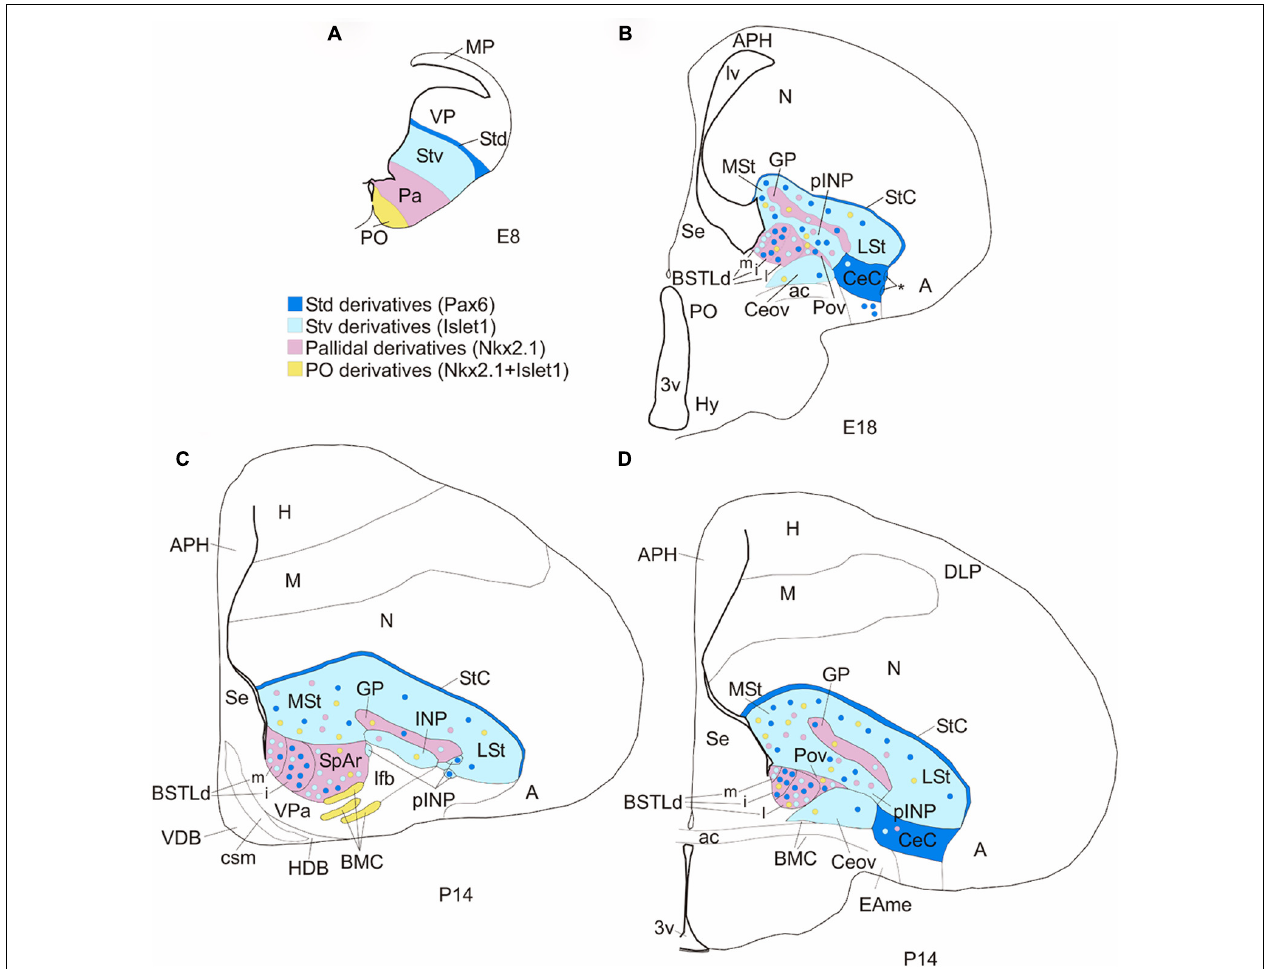
the arcopallial amygdala (A) . (C,D) Schematic drawings of frontal telencephalic sections of juvenile chicks (P14, based on sections from the Chick Brain Atlas by Puelles etal., 2007), at intermediate (C) or caudal (D) levels, representing most of the proposed subdivisions of the central extended amygdala: StC, CeC, Ceov, pINP, Pov, SpAr, and BSTLd (with its medial, intermediate and lateral subdivisions).The subdivisions were drawn following some of the cell masses observed in the corresponding sections from the atlas (stained for Nissl and acetylcholinesterase). See text for more details. For abbreviations, see